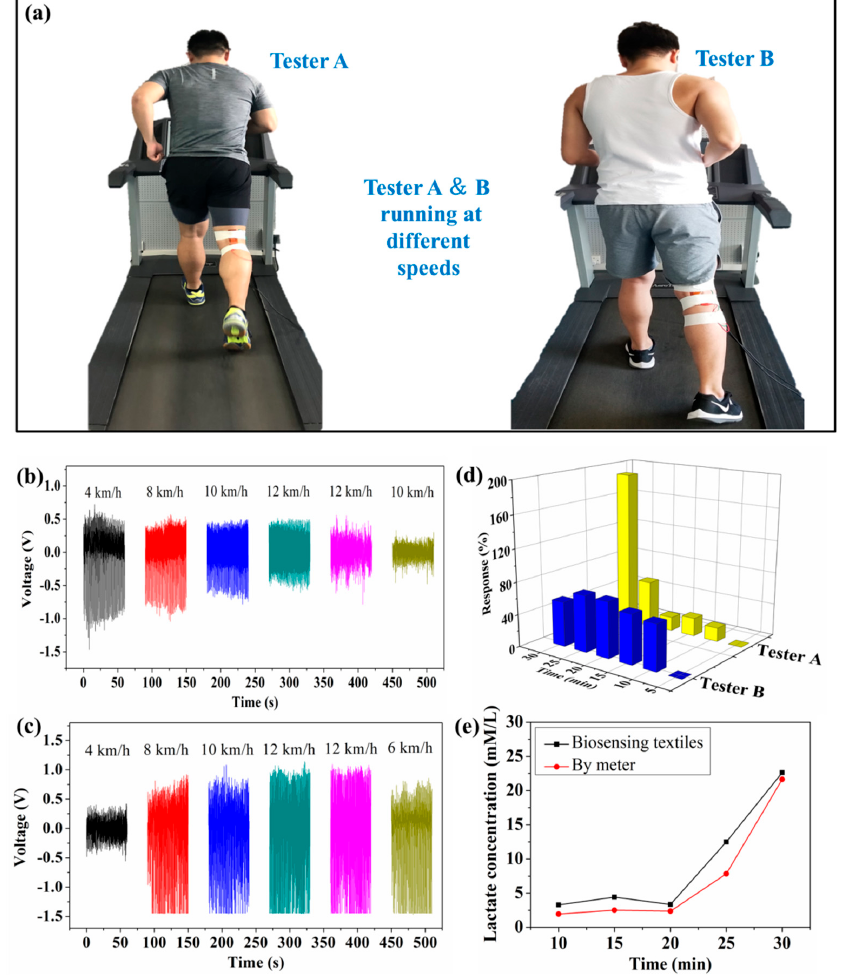
Figure 5. Self-powered piezoelectric-biosensing textiles for monitoring running speed and the physiological state of individual athletes. ( a ) The textiles attached to the two athletes (on the treadmill) for testing. ( b – d ) Real-time monitoring testers A and B. ( e ) The lactate concentration measured by the self-powered piezoelectric-biosensing textiles and commercial meter, respectively.